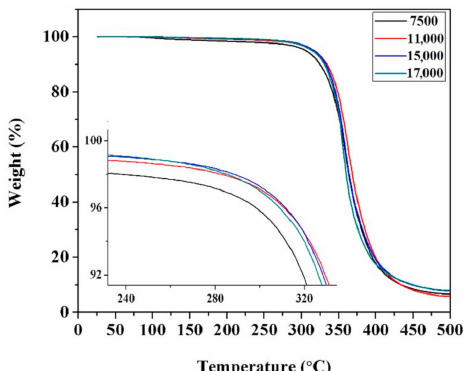
Figure 8. TGA diagram of sizing emulsions with the four di ff erent molecular weights.